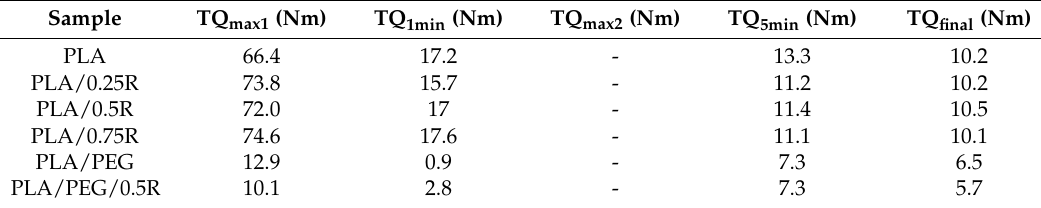
Table 3. Melt processing characteristics of PLA and its blends with rosemary solid extract.